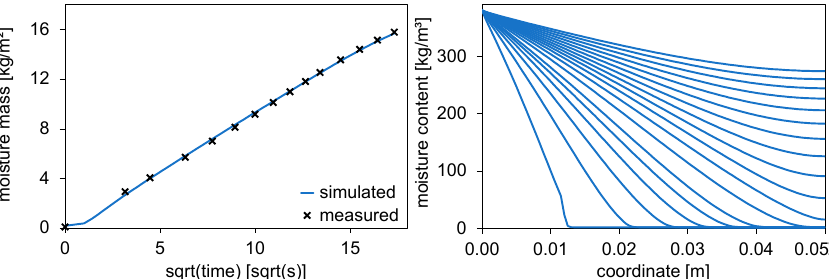
Figure 2. ( left ) Measurement and FLoW1D simulations of capillary absorption for the OPS limestone; the data are depicted as specific moisture mass versus square root of time, the common approach for this experiment, and are equivalent to [1]’s original data; ( right ) FLoW1D-simulated moisture content profiles during capillary absorption, shown every 10 s for the initial minute and then every 20 s for the four remaining minutes.